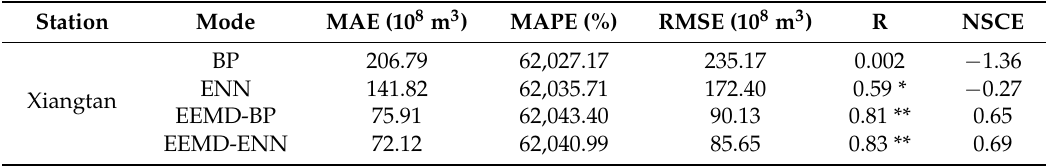
Table 3. Prediction results comparison of ENN and EEMD-ENN